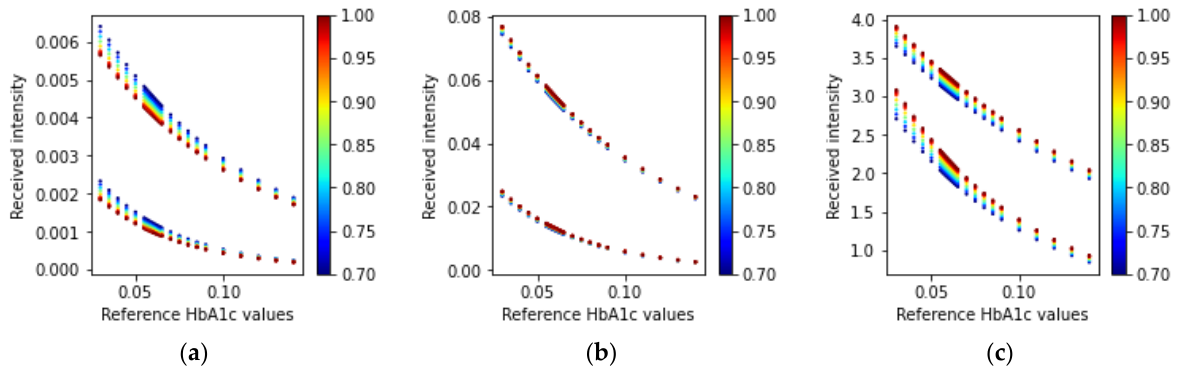
Figure 10. Received intensity values (fingertip: transmission-type) for the three wavelengths: ( a ) 465 nm, ( b ) 525 nm, and ( c ) 615 nm. In each scatter plot, the top adjacent points correspond to the diastolic phase and the bottom points correspond to the systolic phase. The color bars at the side of the plots indicate the different SpO 2 values ranging from 70% to 100%.